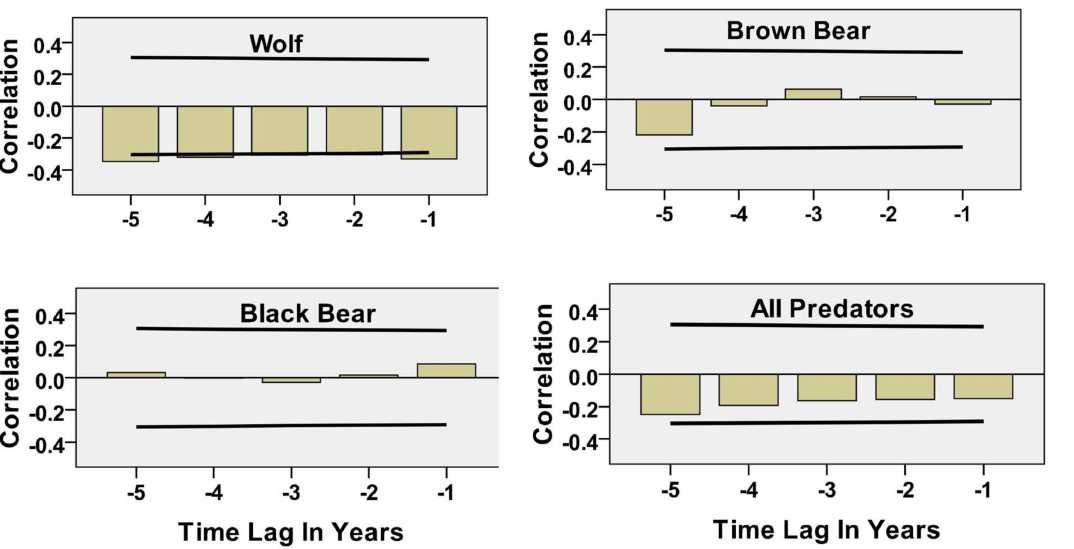
Figure 5. Cross-correlation functions for moose harvest versus previous (1–5 year lag) for wolf, brown bear, black bear, and all predators combined in GMU 13 south-central Alaska, USA, 1973–2020. We only show lags up to 5 years because all significant correlations occurred within those